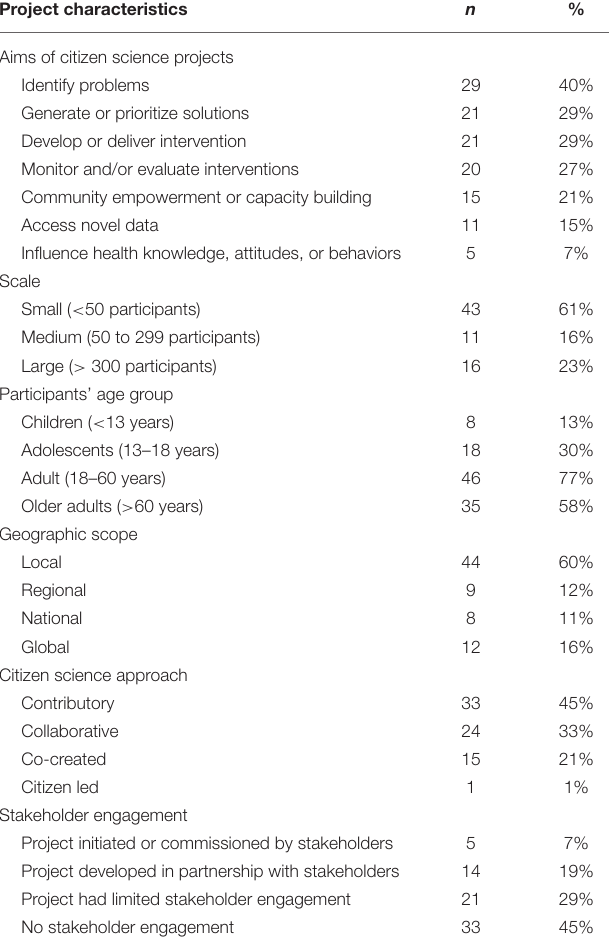
TABLE 1 | Characteristics of citizen science projects in